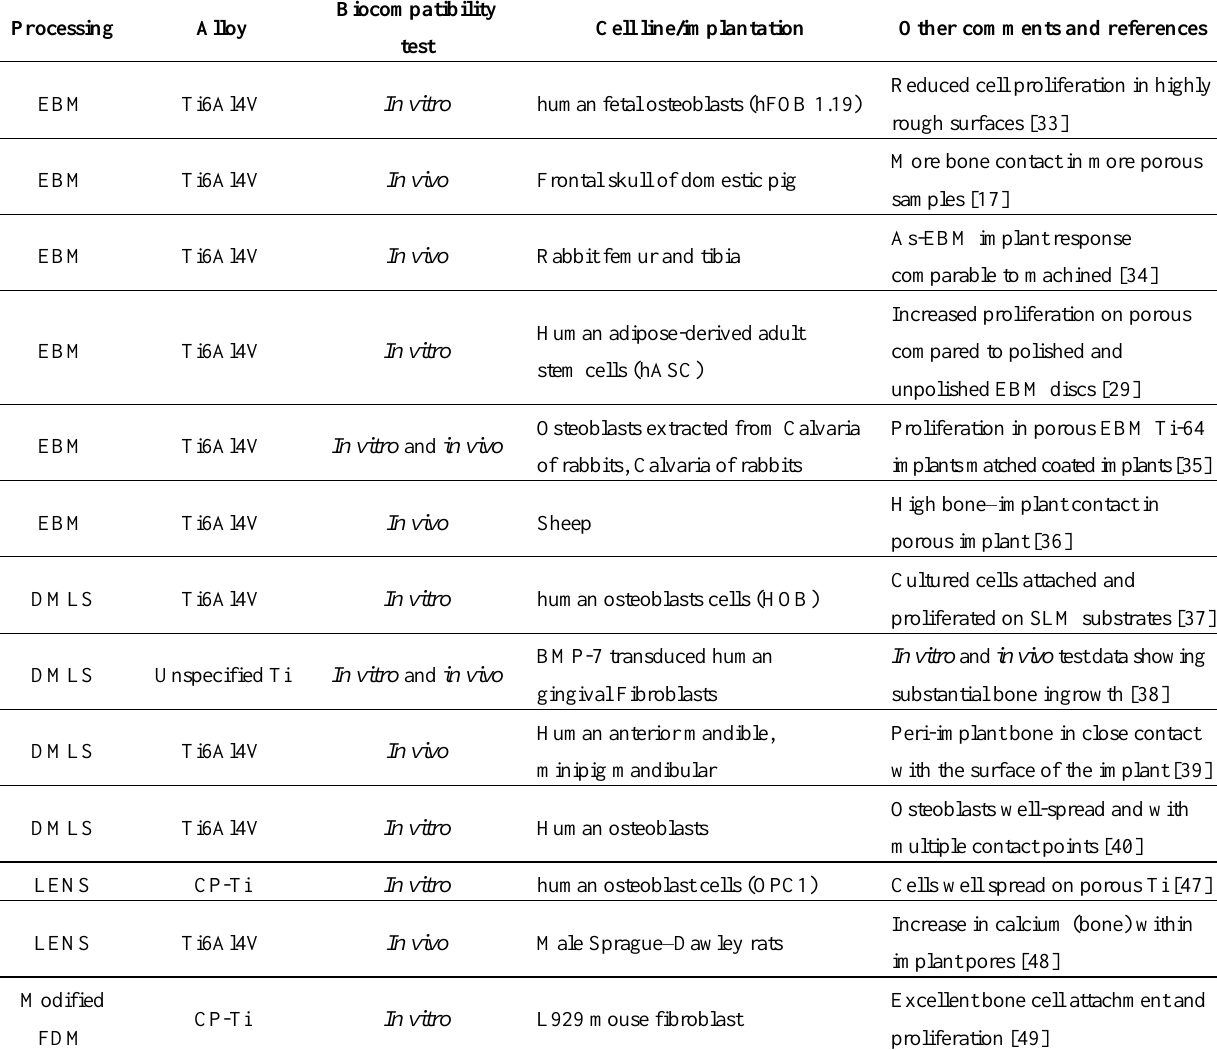
Table 4. Summary of ALM processing methods and